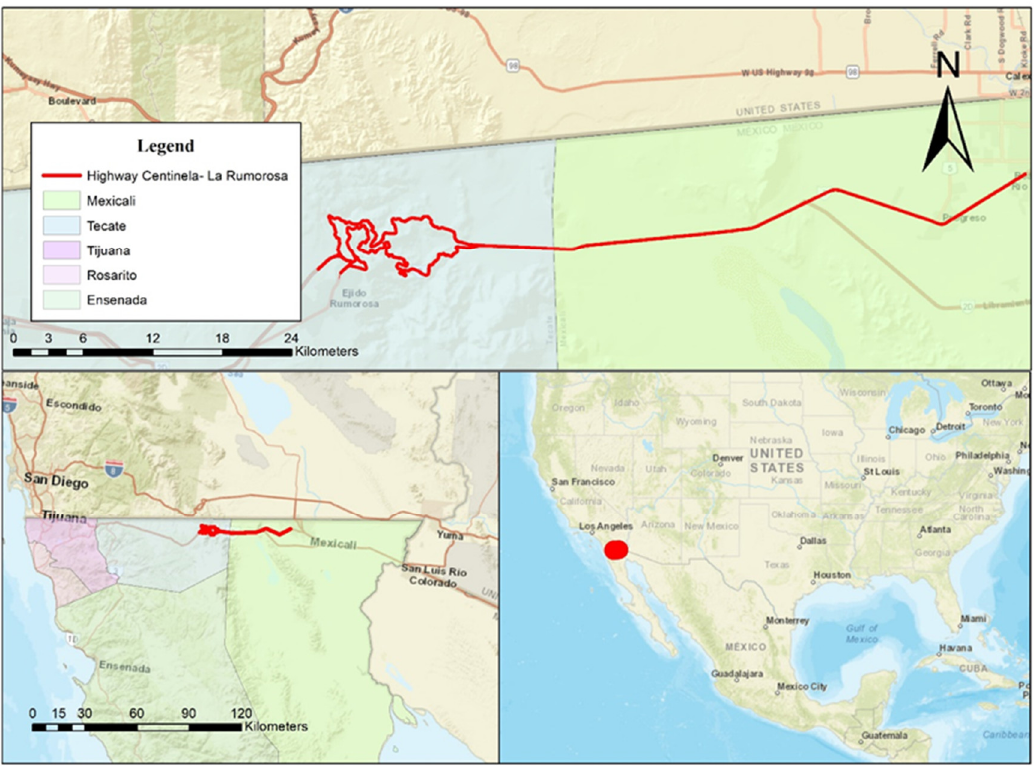
Figure 1. Centinela–La Rumorosa highway location.